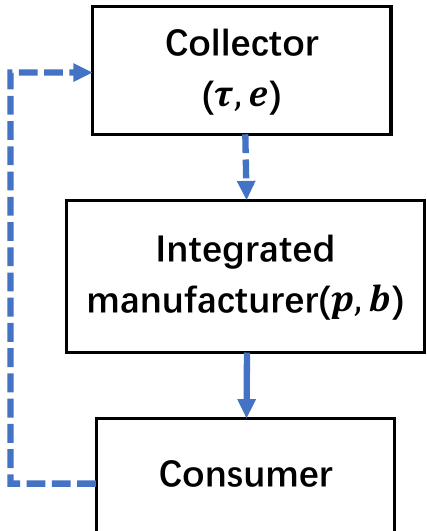
Figure 2. The CLSC structure of model BE